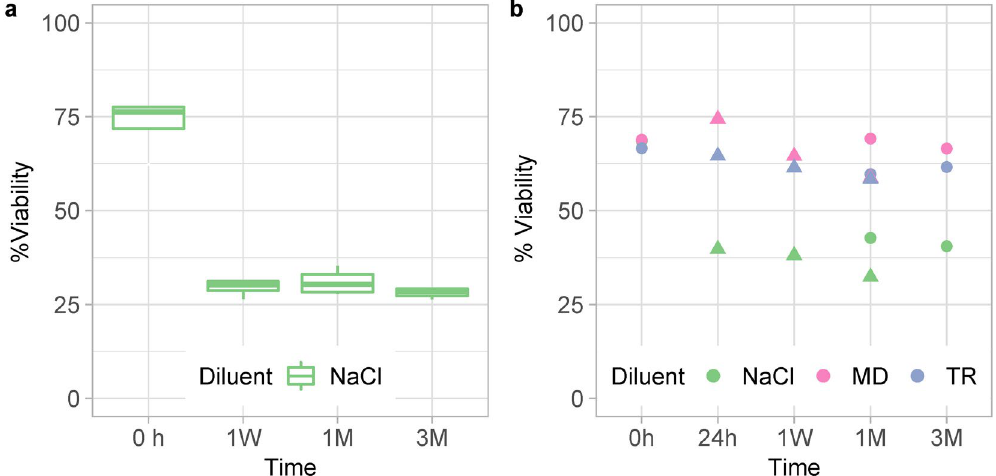
Figure 7. Percent live bacteria in transplants prepared in NaCl ( a , four donations from subjects S2, S3, S4 and S5), or in either NaCl, or MD, or TR ( b , two different donations from subjects S2 -round dots- and S4 -triangular dots-). Transplants were frozen by fractions in a -80 °C standard freezer, and then rapidly thawed at defined times (24h: 24 hours, 1W: 1 week, 1M: 1 month, 3M: 3 months) for live/dead tests by flow cytometry. Viabilities at 0 hour are those measured before freezing.